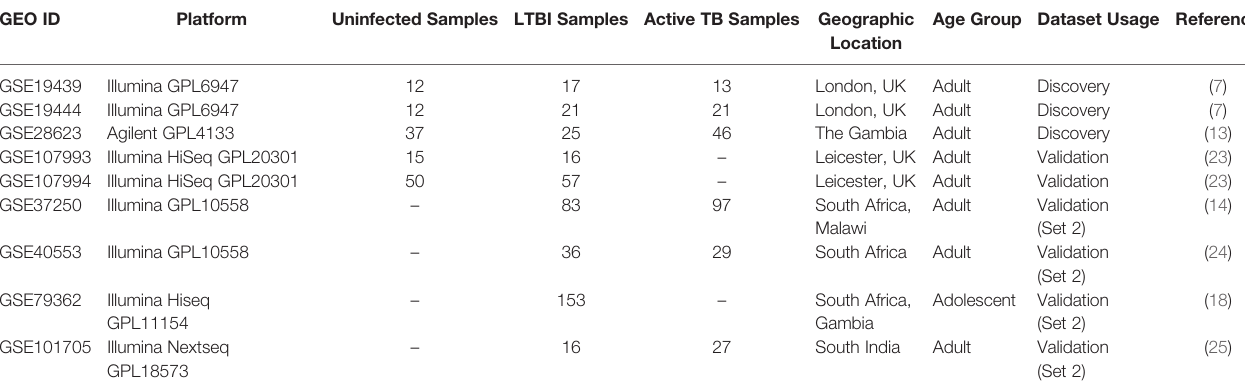
TABLE 1 | Blood transcriptome datasets obtained from GEO satisfying the inclusion criteria as mentioned in Methods section. GEO ID